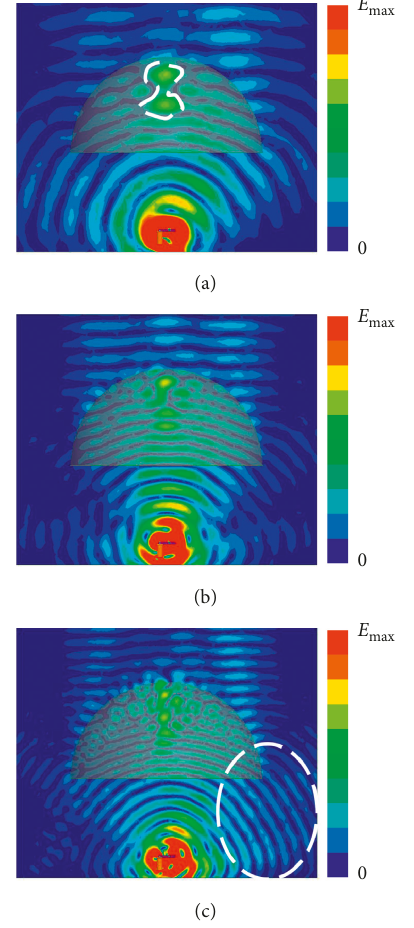
Figure 6: Ultra-wideband dielectric lens electric field magnitude analysis. (a) f � 7.0GHz, (b) f � 10.0GHz, and (c) f � 13.0